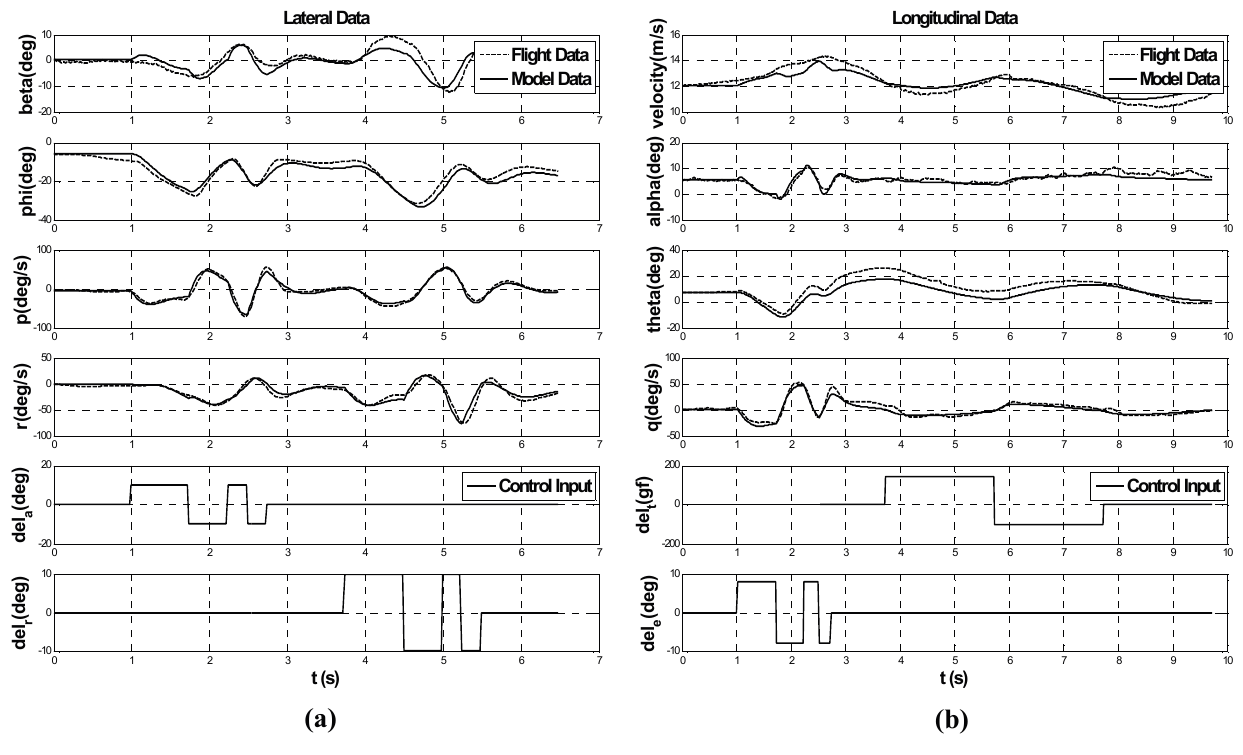
Figure 3. ( a ) Lateral; and ( b ) longitudinal system ID results for target